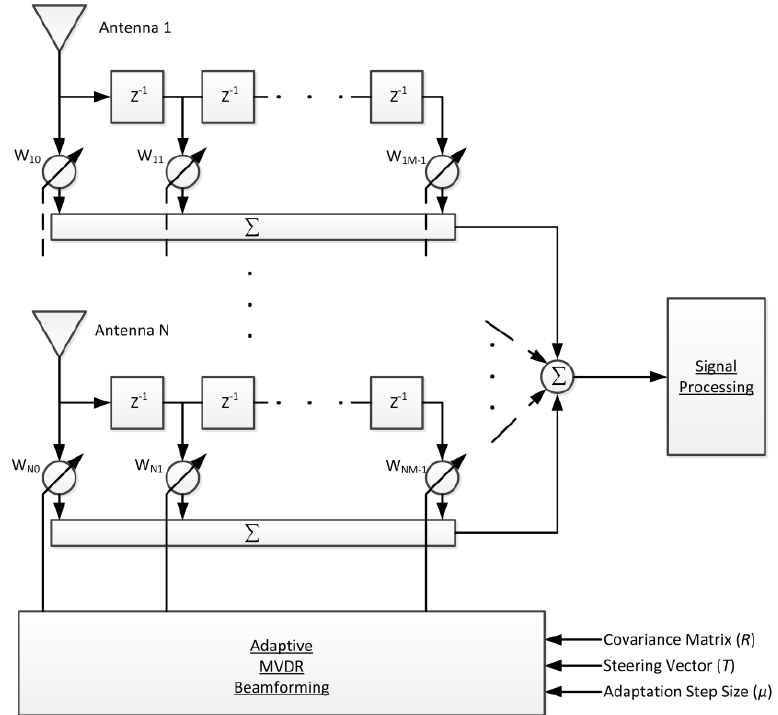
Figure 1. Architecture of STAP with adaptive MVDR beamforming